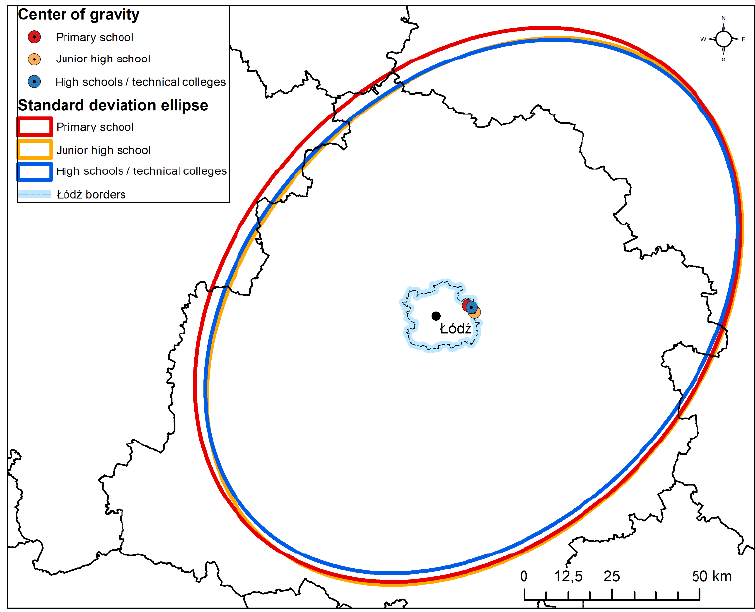
Figure 7. Distribution of schools completed by the students under study (excluding the student educated in Athens (Greece)).